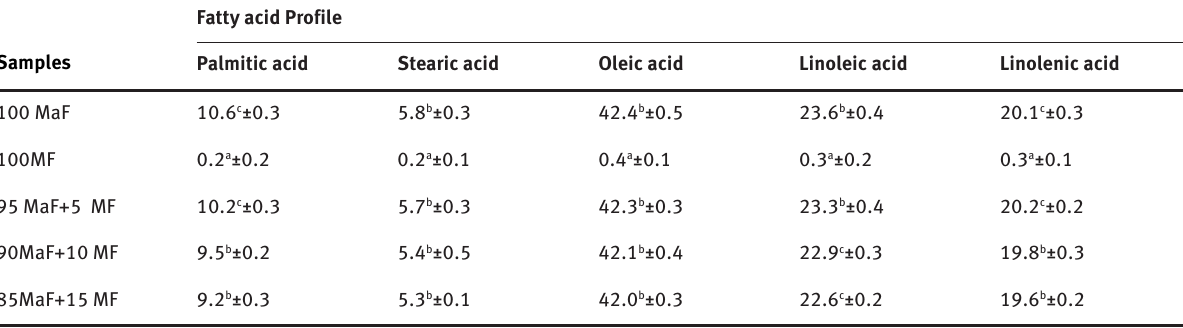
Table 5: Fatty acids profile (mg/g) of maize and oyster mushroom flour and their blends Fatty acid